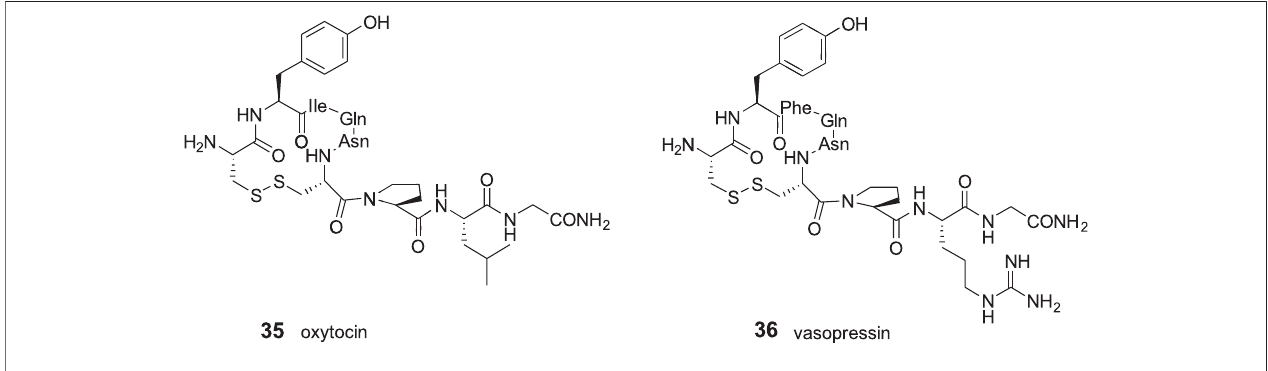
Figure 8 | The macrocyclic disul fi des oxytocin ( 35 ) and vasopressin ( 36 ) are IRAP